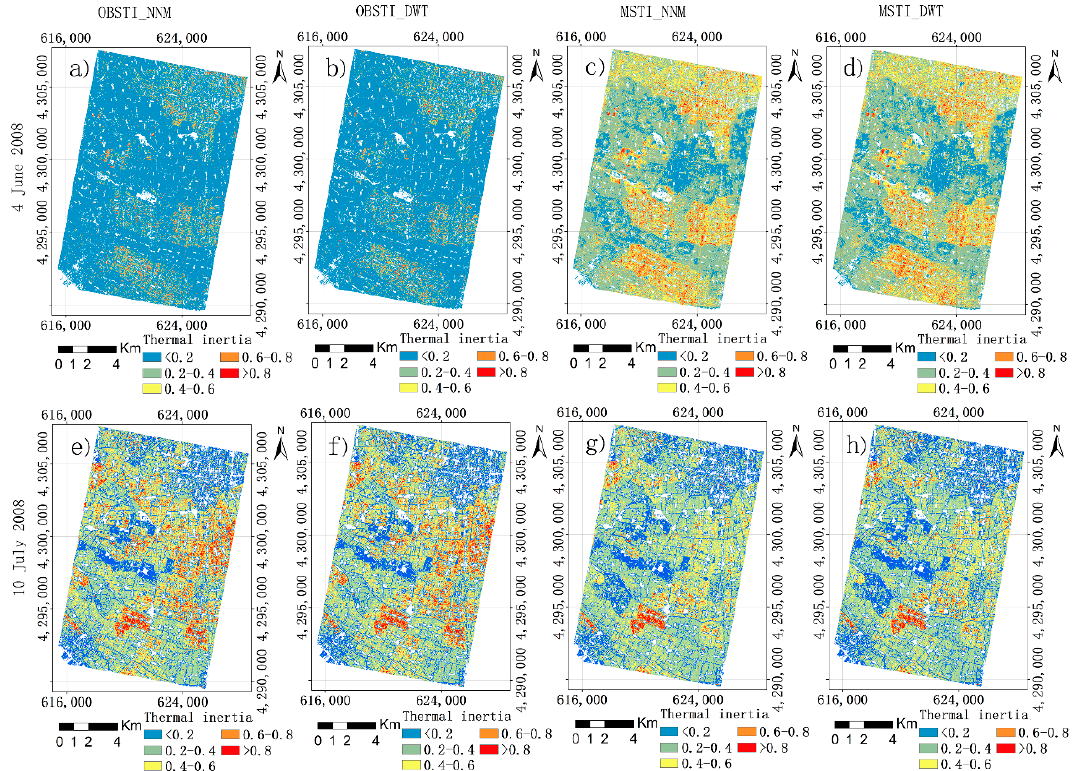
Figure 12. Spatial distributions of four combinations with images dated on June 4th and July 10th 2008: OBSTI_NNM—the original-model-based bare STI using the 15 m resolution thermal infrared bands by re-sampling using the nearest neighbor method; OBSTI_DWT—the original-model-based bare STI using the 15 m resolution fusion thermal infrared bands; MSTI_NNM—the modified-model-based STI using the 15 m resolution thermal infrared bands by re-sampling using the nearest neighbor method; and MSTI_DWT—the modified-model-based STI using the 15 m resolution fusion thermal infrared bands. Spatial distributions of thermal inertia derived using ( a , e ) OBSTI_NNM; ( b , f ) OBSTI_DWT; ( c , g ) MSTI_NNM; and, ( d , h ) MSTI_DWT on June 4th and July 10th 2008, respectively.